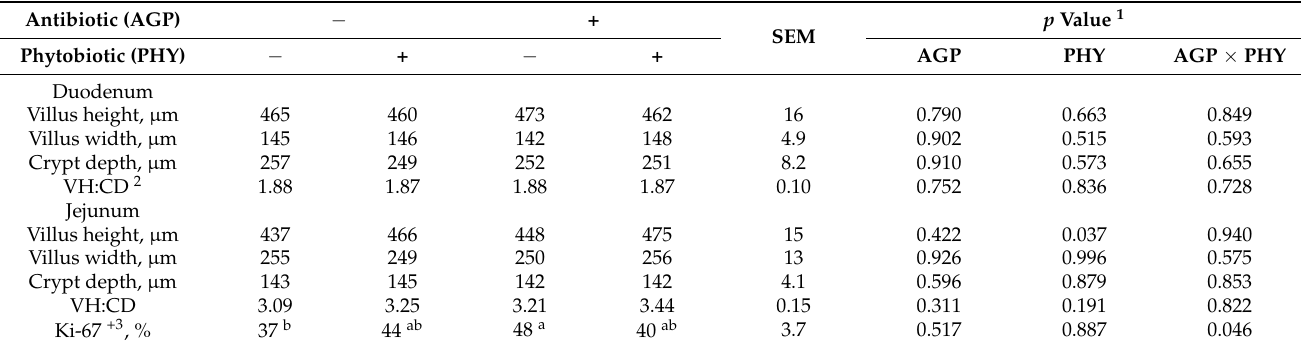
Table 8. Intestinal morphology and crypt cell proliferation in nursery pigs fed diets supplemented with phytobiotics and antibiotics as growth promoters (Exp. 1).